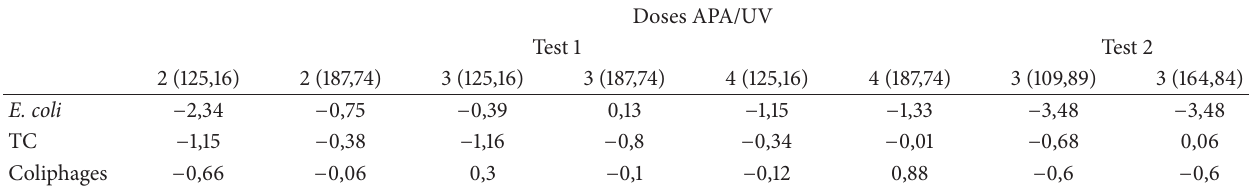
Table 3: Synergy verification.